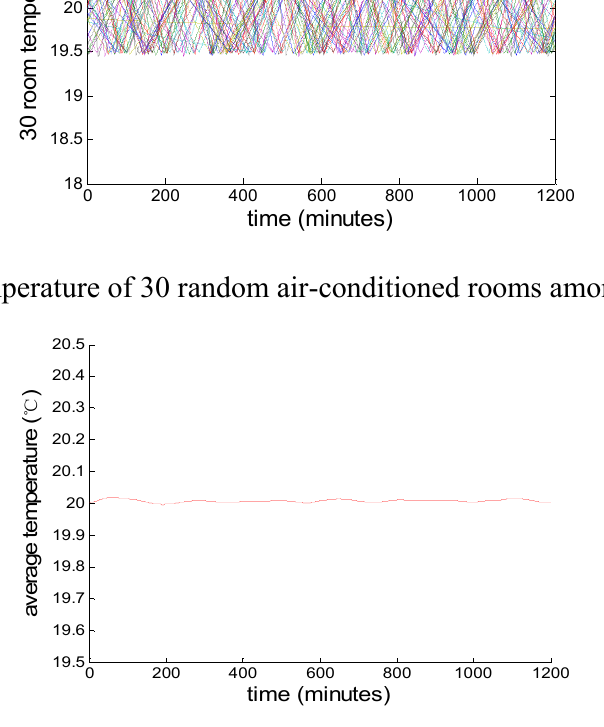
Figure 12. The mean temperature inside the houses of all